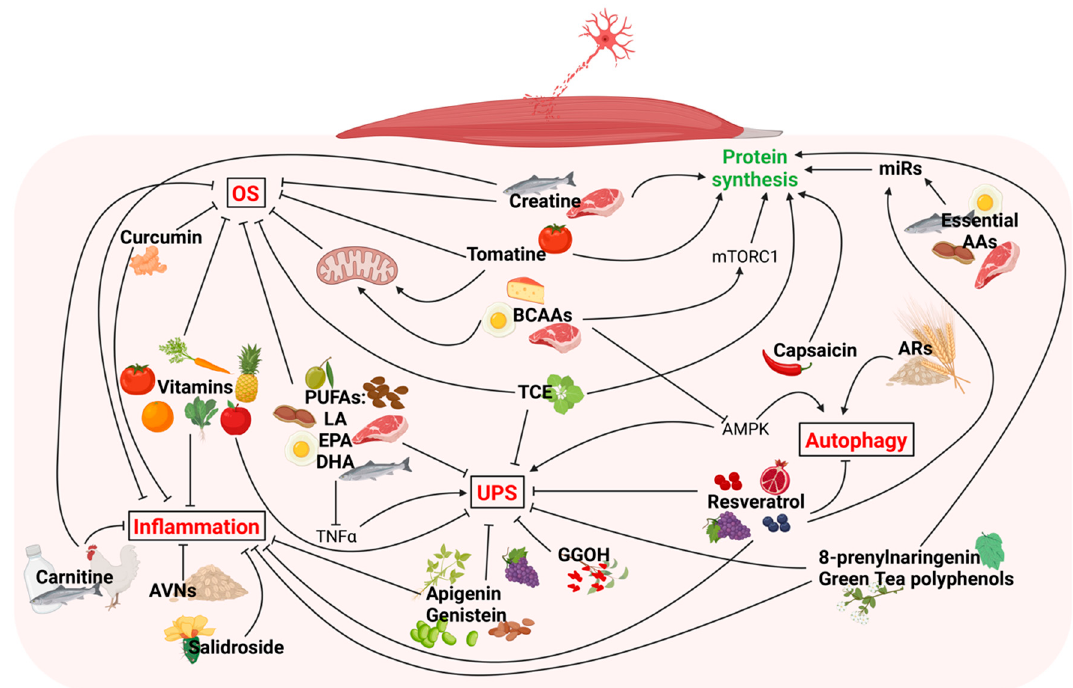
Figure 2. Functional nutrients able to prevent denervation-induced skeletal muscle atrophy by decreasing muscle catabolism or increasing muscle anabolism. In red are mentioned the pathways promoting muscle atrophy, while in green the one preserving muscle mass.